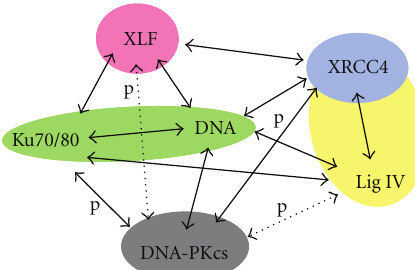
Figure 1: Schematic diagram of interactions of the NHEJ machin- ery. Colour-filled shapes indicate the proteins and complexes with known 3D structures. Solid arrows indicate confirmed whereas dashed arrows are plausible interactions. Phosphorylation events are indicated by letter